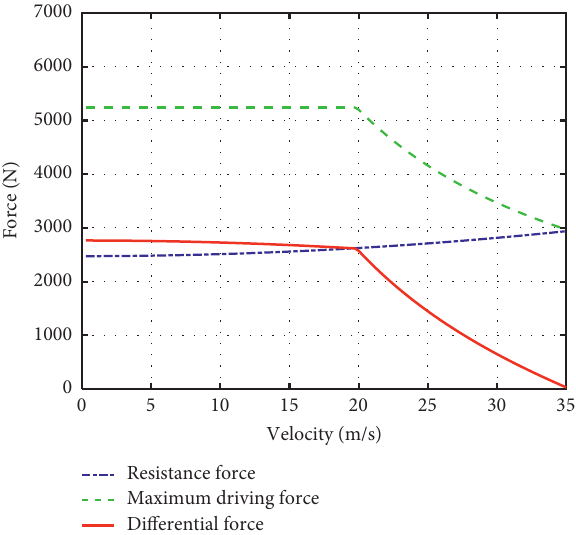
Figure 6: Variation of the force in the longitudinal